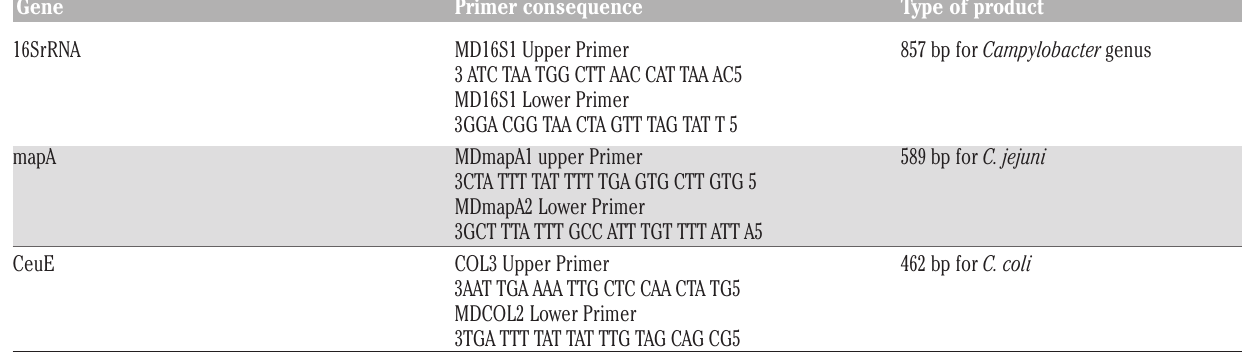
Table 1. Sequences of primers used for detecting Campylobacter and the related Jejuni and Coli species. Gene